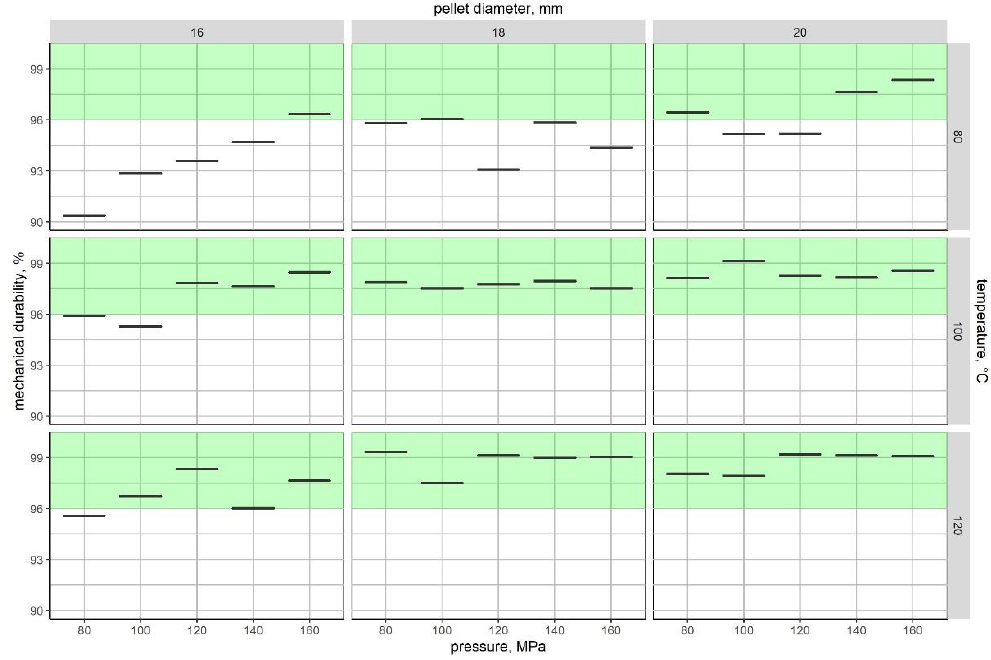
Figure 11. Variation of the expansion coefficient with compaction pressure, temperature, and pellet diameter. The grey line in each plot represents the average value of each group. Top and bottom of each box represents range of values deviation.